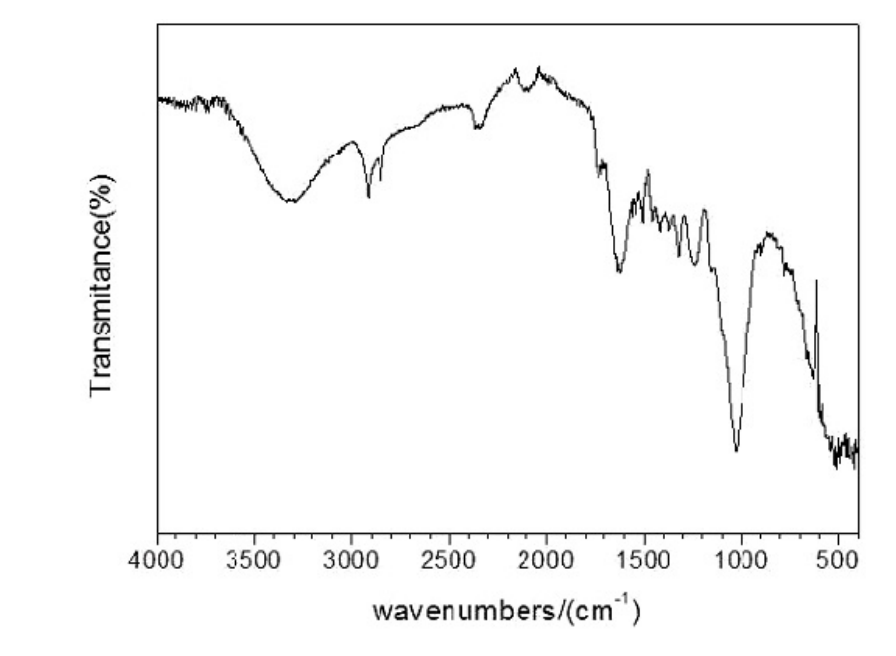
FIGURE 2 – Infrared spectrum of the vegetal drug from T.